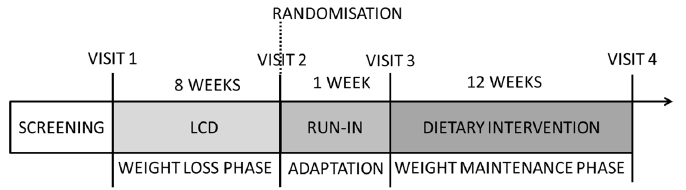
Figure 1. Experimental design of the study. LCD: low ‐ calorie diet.